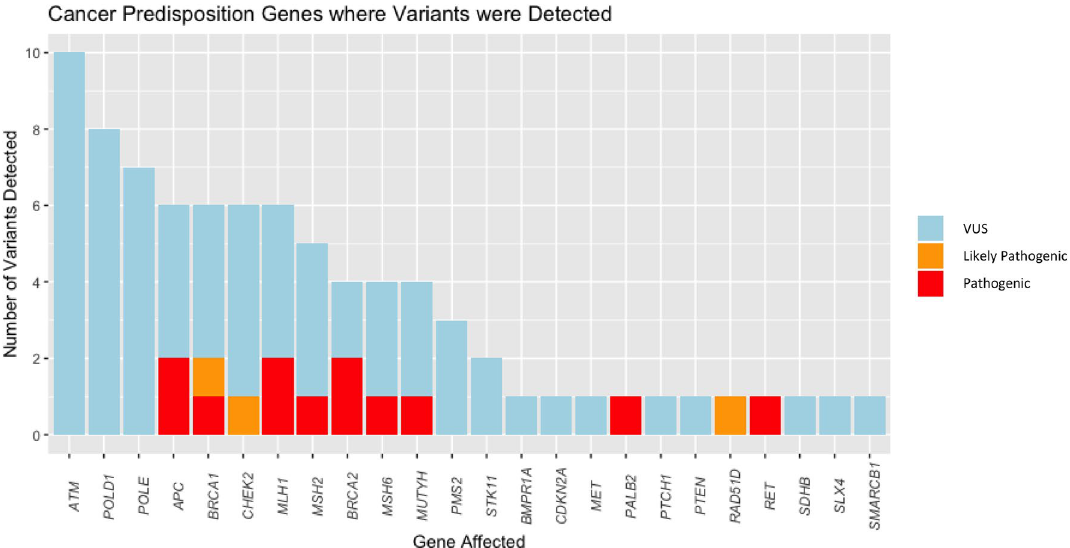
Figure 3. Cancer predisposition genes detected, sub-divided by the type of variant